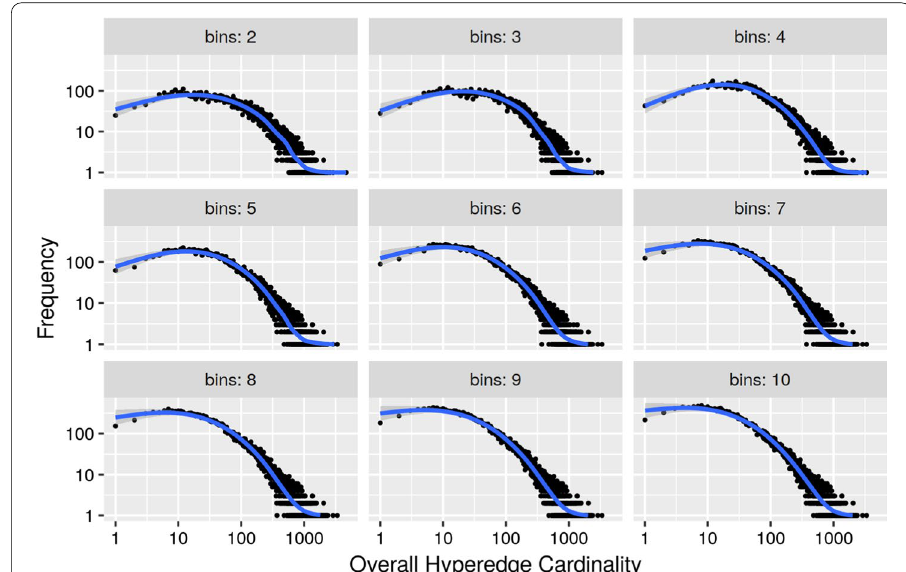
Fig. 22 TF-bin hyperedge cardinality distribution (log–log scale)